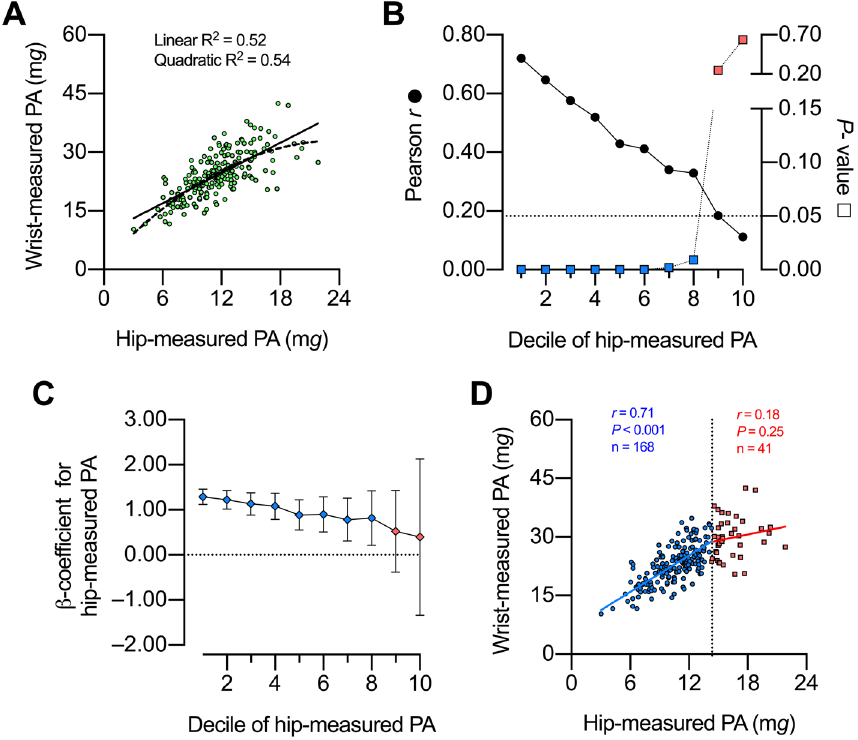
Figure 1. Association between wrist-measured and hip-measured physical activity [PA] in adults. ( A ) Quadratic [dashed line] and linear [solid line] regression models. ( B ) Pearson r [circles] and P values [squares; blue for statistically significant, and red for non-significant] for the associations between wrist-measured PA and hip-measured PA that include subjects from different deciles of hip-measured PA until the 10th decile; e.g. values for decile 9th indicate a correlation that includes subjects from the 9th to the 10th deciles. ( C ) Unstandardized ß-coefficients and 95% confidence intervals for the linear regression between wrist-measured PA vs. hip-measured PA that include subjects spanning different deciles of hip-measured PA, as explained in B. Blue symbols indicate significantly different from zero; red symbols indicate non-significantly different from zero ( D ) Threshold of hip-measured PA [dotted line; 14.33 mg] beyond which the association with wrist- measured PA becomes non-significant. n =